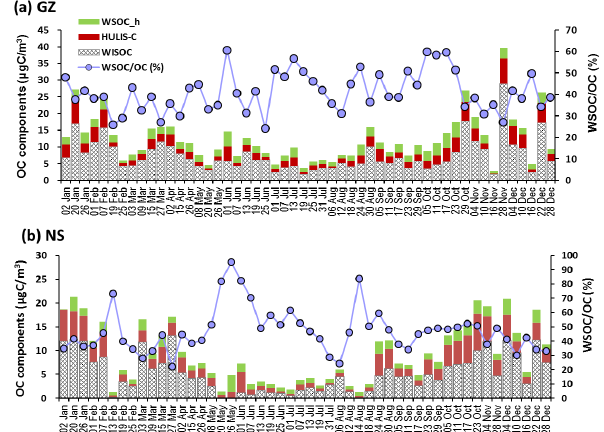
Figure 2. Spatial and temporal variation of OC fractions (i.e., HULIS-C (HULIS-carbon), WSOC_h (hydrophilic water-soluble organic carbon), WISOC (water-insoluble organic carbon)) shown as stacked bars throughout the sampling year 2009. Data of the per- cent of WSOC in OC are shown as line